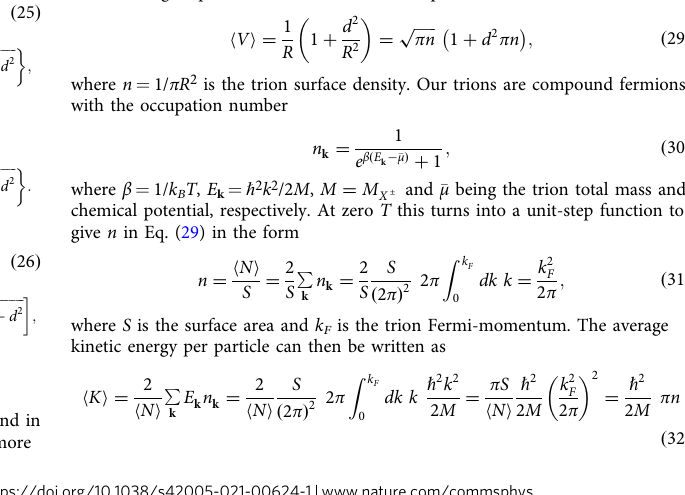
p(cid:14) ffiffiffiffiffiffiffiffiffiffiffiffiffiffiffiffi R 2 þ d 2